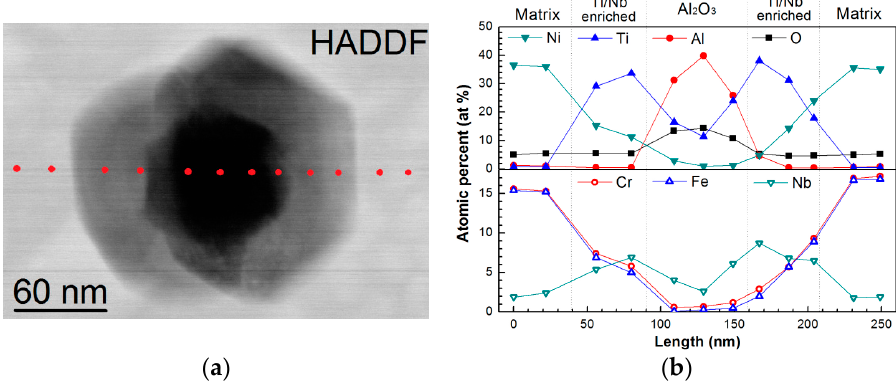
Figure 4. The STEM EDS point analysis on the residue of the EBM-fabricated IN718 sample.